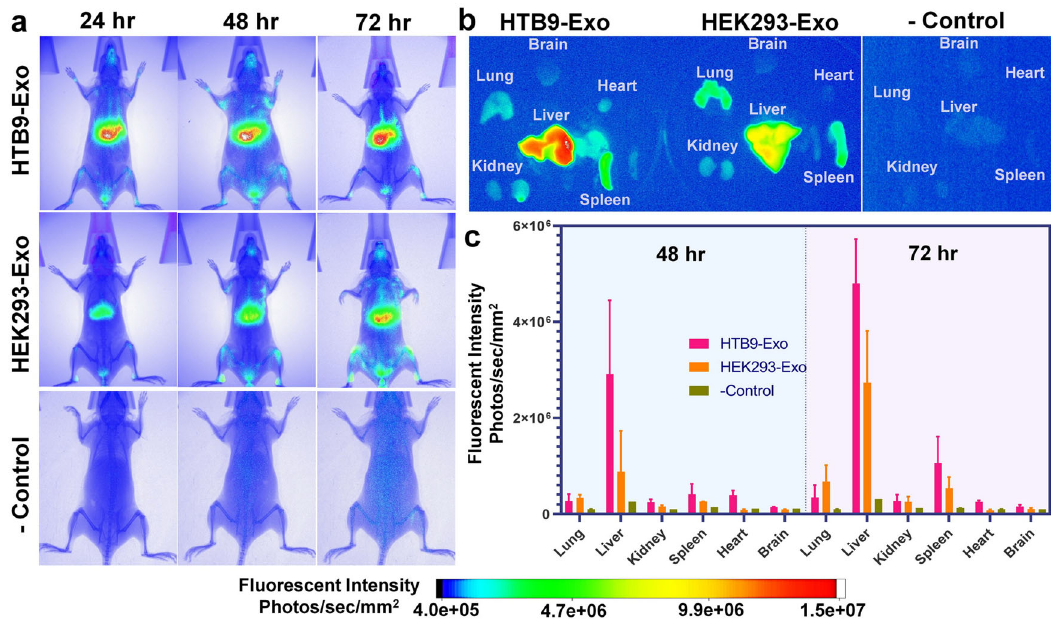
Fig. 6 In vivo biodistribution analysis of NanoPoms prepared exosomes. a Representative IVIS images at 24 h, 48 h, and 72 h post-injection of live mice. The HTB9 tumor cell derived exosomes and non-malignant HEK cell derived exosomes with DiR labeling (2.0 × 10 9 particles/ml) were prepared by NanoPoms approach for intravenous tail injection into BALB/cJ mice. The buffer solution without exosomes was used as the negative control. b Representative IVIS images of harvested organs (lung, liver, kidney, spleen, heart, and brain) at 48 h and 72 h post injection from mice. c The fl uorescence signals normalized with negative control from IVIS images in each organ harvested at 48 h and 72 h post injection ( n = 2 biologically independent animals, mean ±